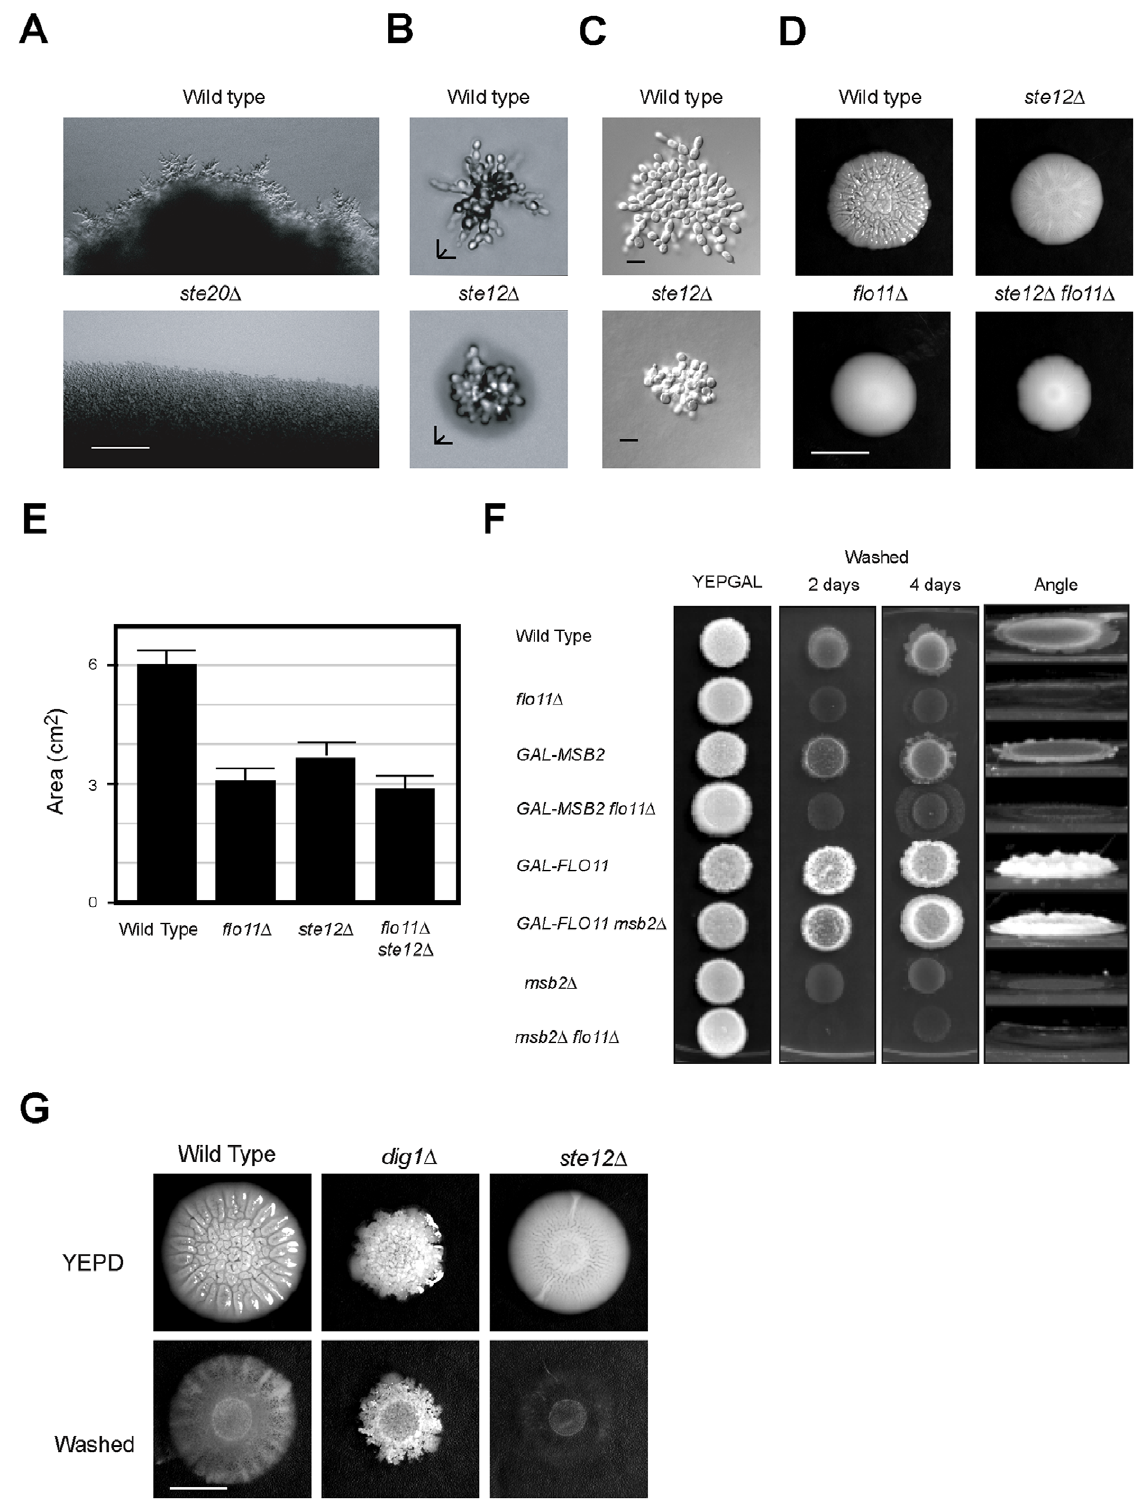
Figure 2. The filamentous growth pathway regulates foraging responses. A ) Microscopic examination of mat perimeters grown on YEP 0.3% agar medium; top panel, wild-type cells (PC313), bottom panel ste20 D mutant (PC549). Bar=50 m M. B ) The formation of pseudohyphae in filamentous mats is dependent on the MAPK pathway. Wild type (PC538) and the ste12 D (PC539) mutant were spotted onto synthetic media (lacking glucose) in 0.3% agar medium for 24 h at 30 u C. A compiled Z-stack rendering of typical microcolonies are shown. Bar=10 microns. C ) Same strains in 2B were examined on rich medium lacking glucose (YEP) in 0.3% agar. A representative microscopic image is shown. Bar=10 microns. D ) Genetic analysis of the roles of the MAPK pathway and Flo11 in mat formation. Cells of the indicated genetic backgrounds were spotted onto YEPD media (0.3% agar) for 4 days and a representative mat was photographed. Bar=1 cm. E ) Quantitation of the surface area of the mats in D. Mats were